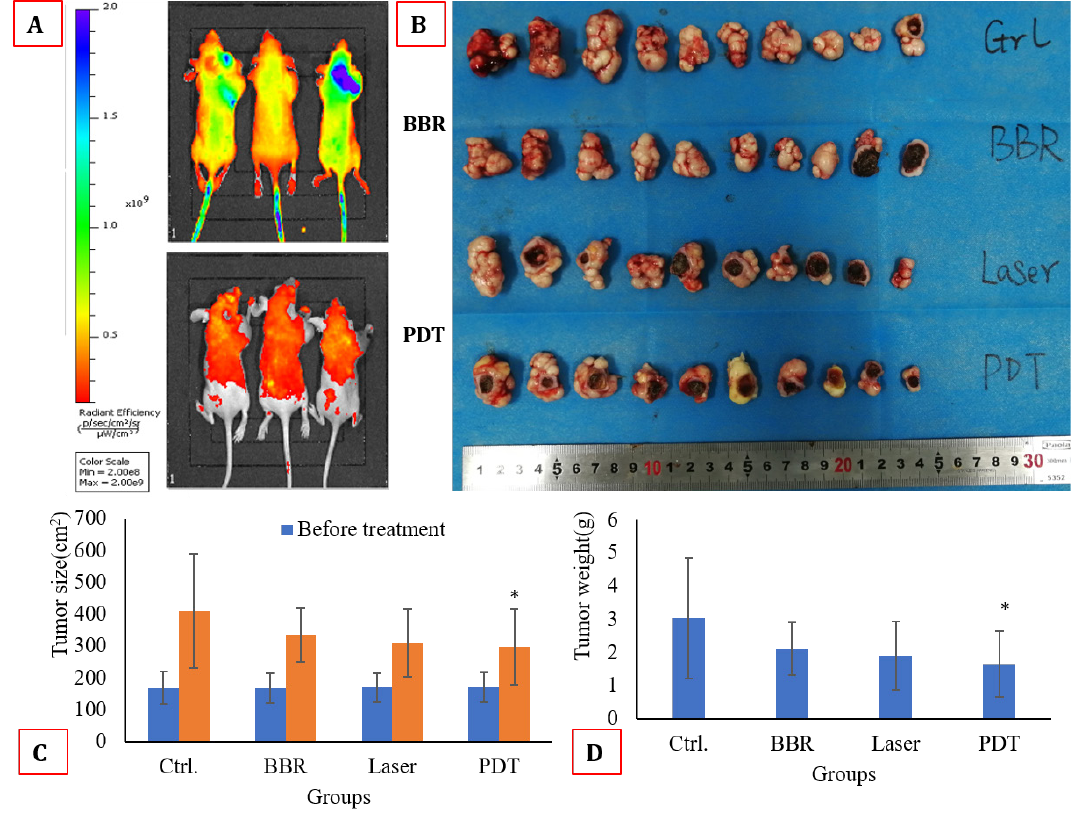
Figure 3: In vivo antitumor effects of BBR-mediated PDT in the xenograft model. N = 10, means ± SD. (A). In vivo fluorescence measurement. (B). Anatomical tumors in the different treatment groups. (C). Comparison of tumor size both before and after treatment (cm 2 ). (D). Comparison of tumor weight (g). The dose of BBR was 10 mg/kg. PDT was performed using a 405 nm laser unit with a luminous flux of 1000 mW/cm 2 for 1 min. * P < 0.05, vs control